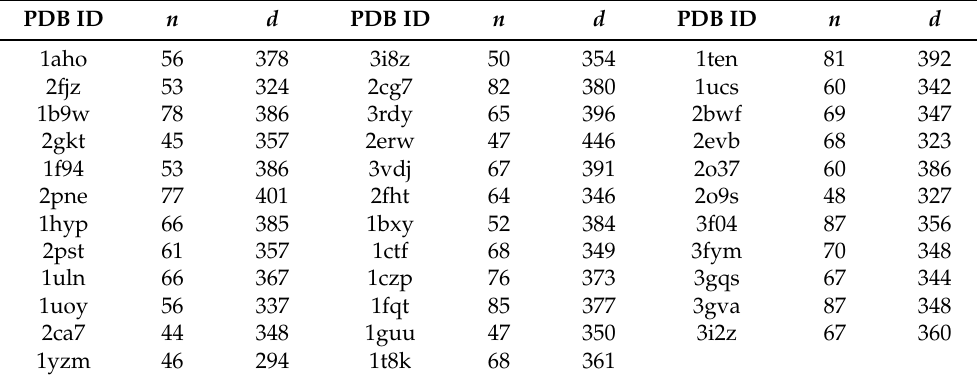
Table 1. List of protein structures used in our benchmark set, for full redesign: pdb identifier, domain length n (number of variables in the resulting CFN) and maximum domain size d